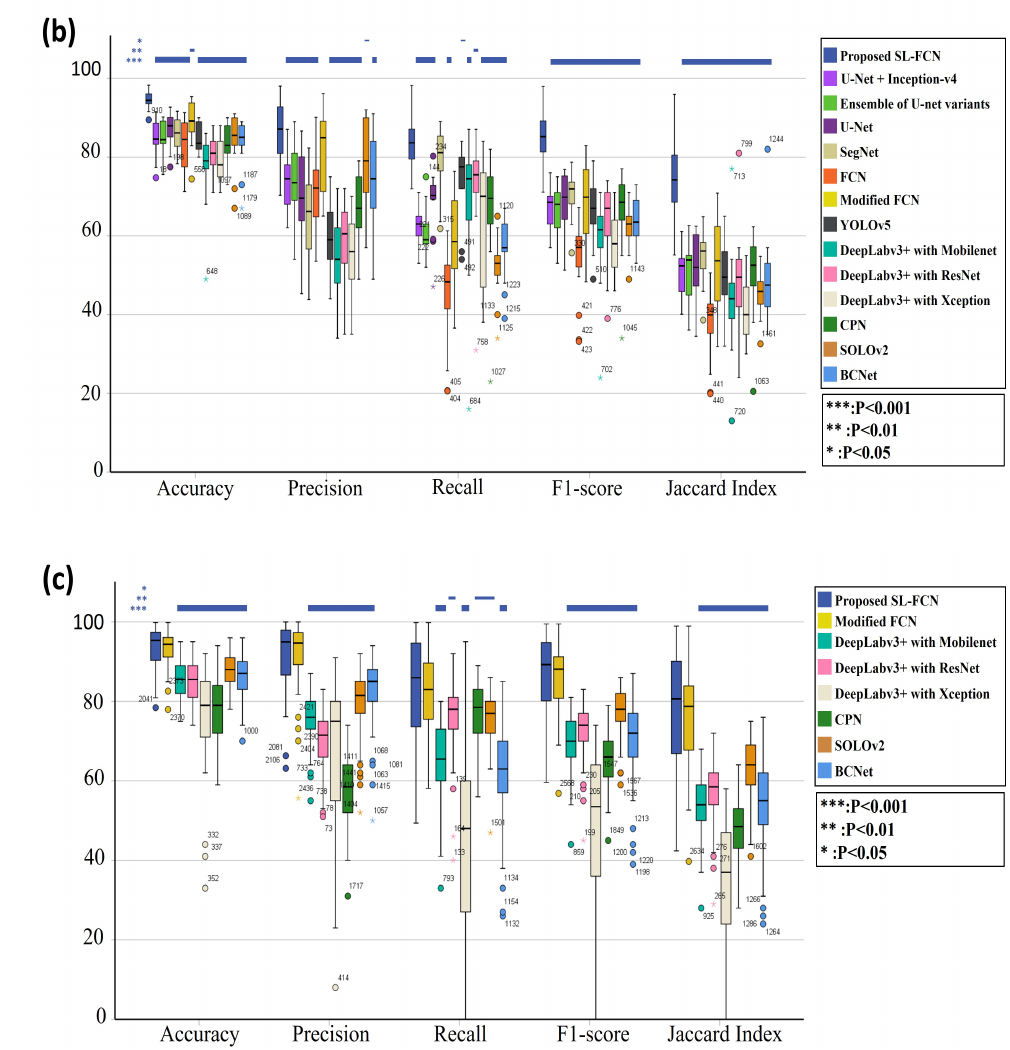
Figure 3. The box plots of quantitative evaluation results of the three breast cancer datasets, including ( a ) DISH dataset 1; ( b ) DISH dataset 2; ( c ) FISH